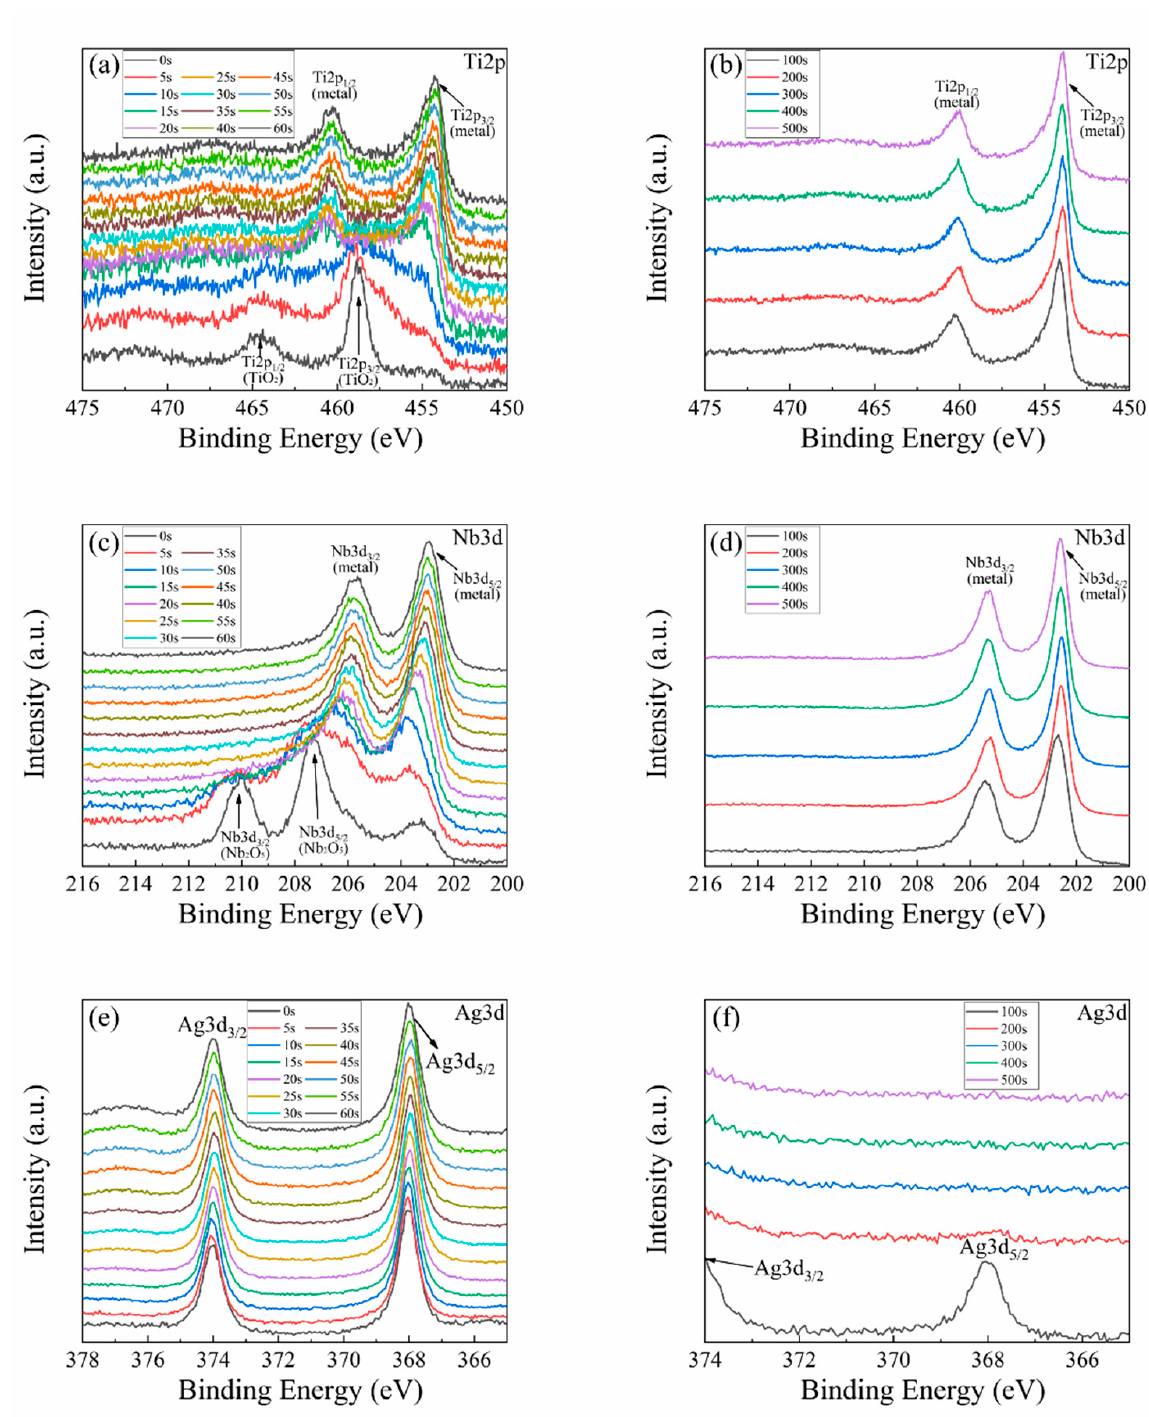
Figure 5. XPS depth distribution map of each element in the Ag-implanted layer: ( a , b ) XPS spectra of Ti-2p, ( c , d ) XPS spectra of Nb-3d, and ( e , f ) XPS spectra of Ag-3d.